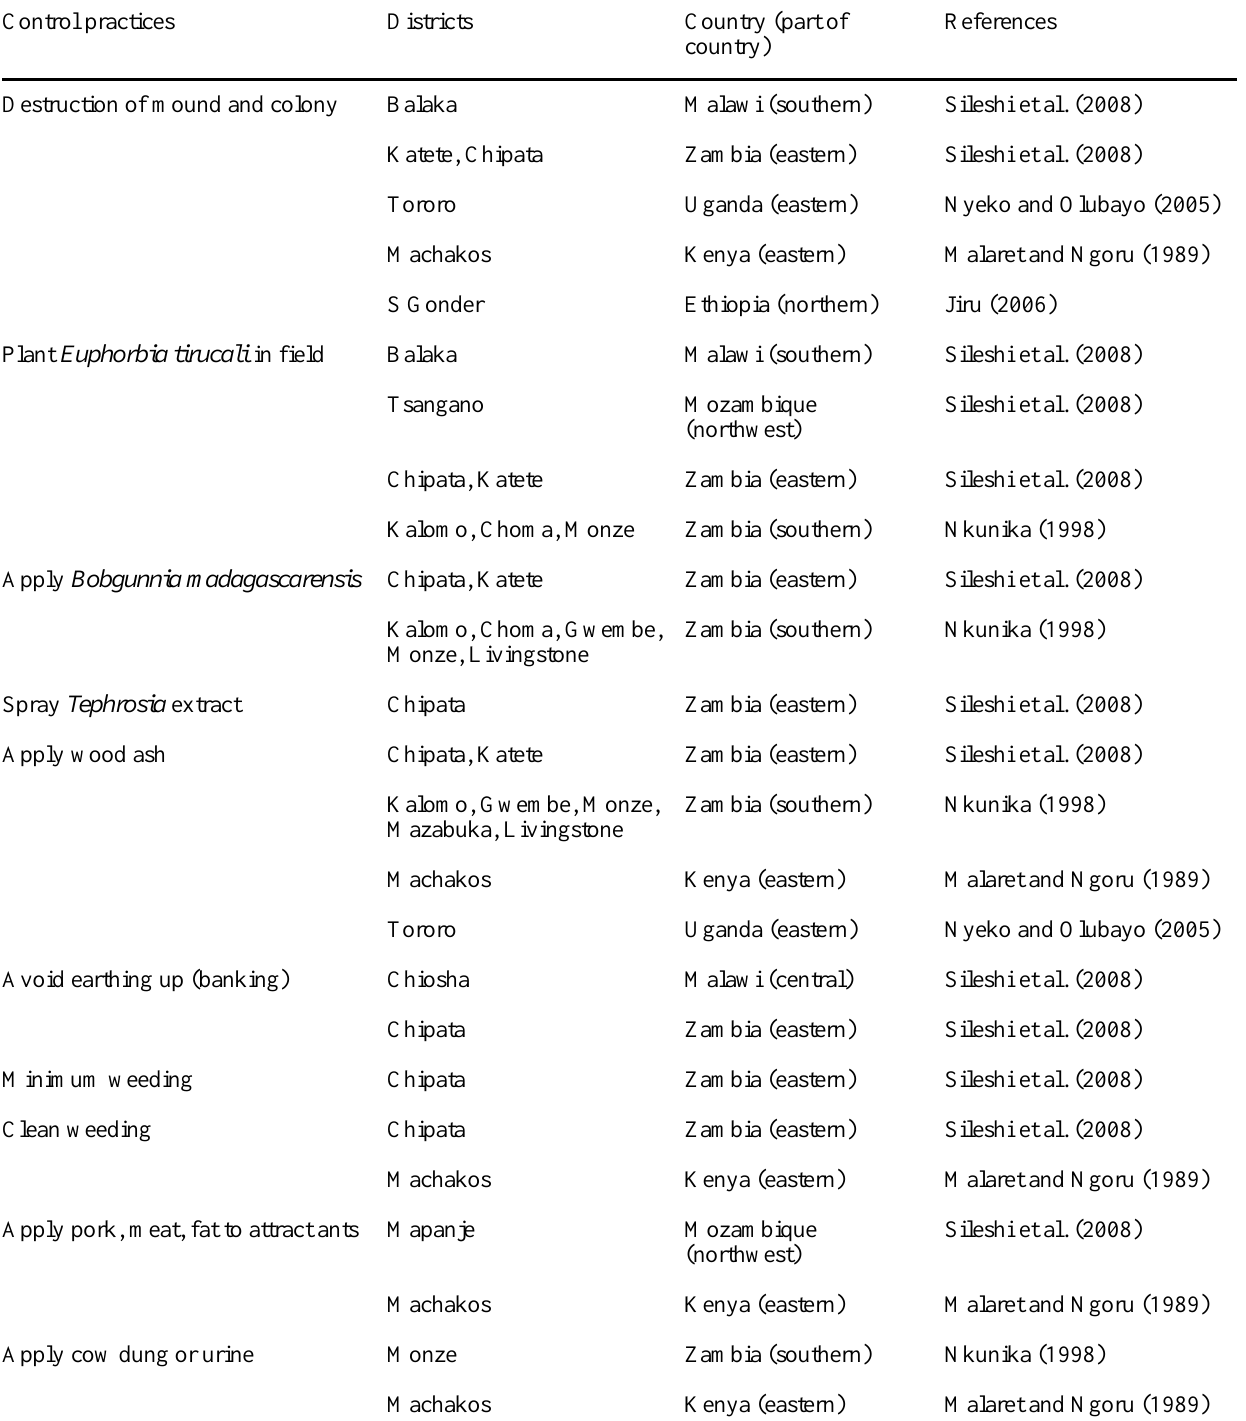
Table 4. Farmers’ indigenous termite management practices in Ethiopia, Kenya, Uganda, Malawi, and